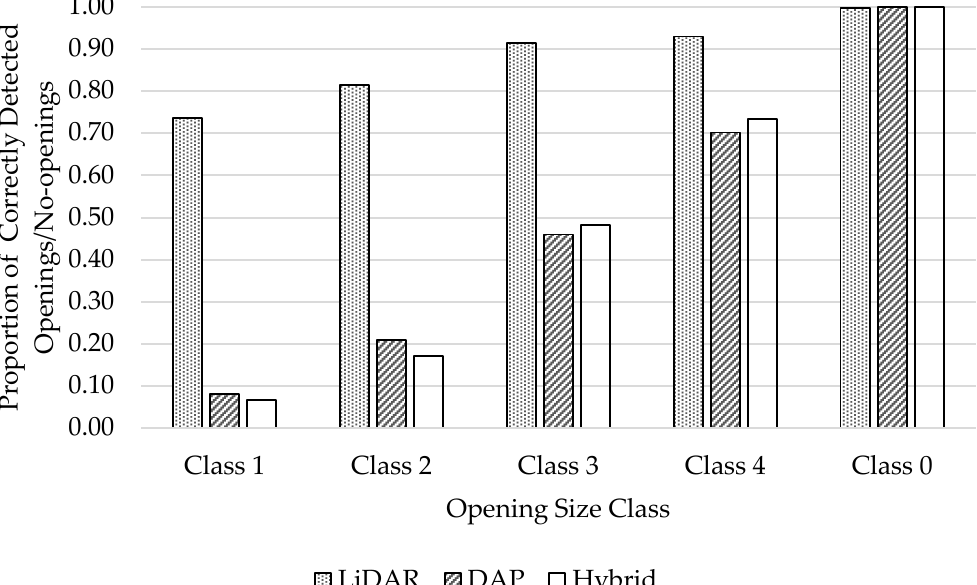
Figure 6. Results of canopy opening and no-opening detection presenting the proportion of correctly detected openings, relative to their size class. Class 0 is no-opening, Class 1 is openings > 0–4 m 2 , Class 2 is openings > 4–20 m 2 , Class 3 is openings > 20–200 m 2 , and Class 4 is openings > 200 m 2 . The evaluation of size class-dependent detection rates is based on the average of 100 sample runs.